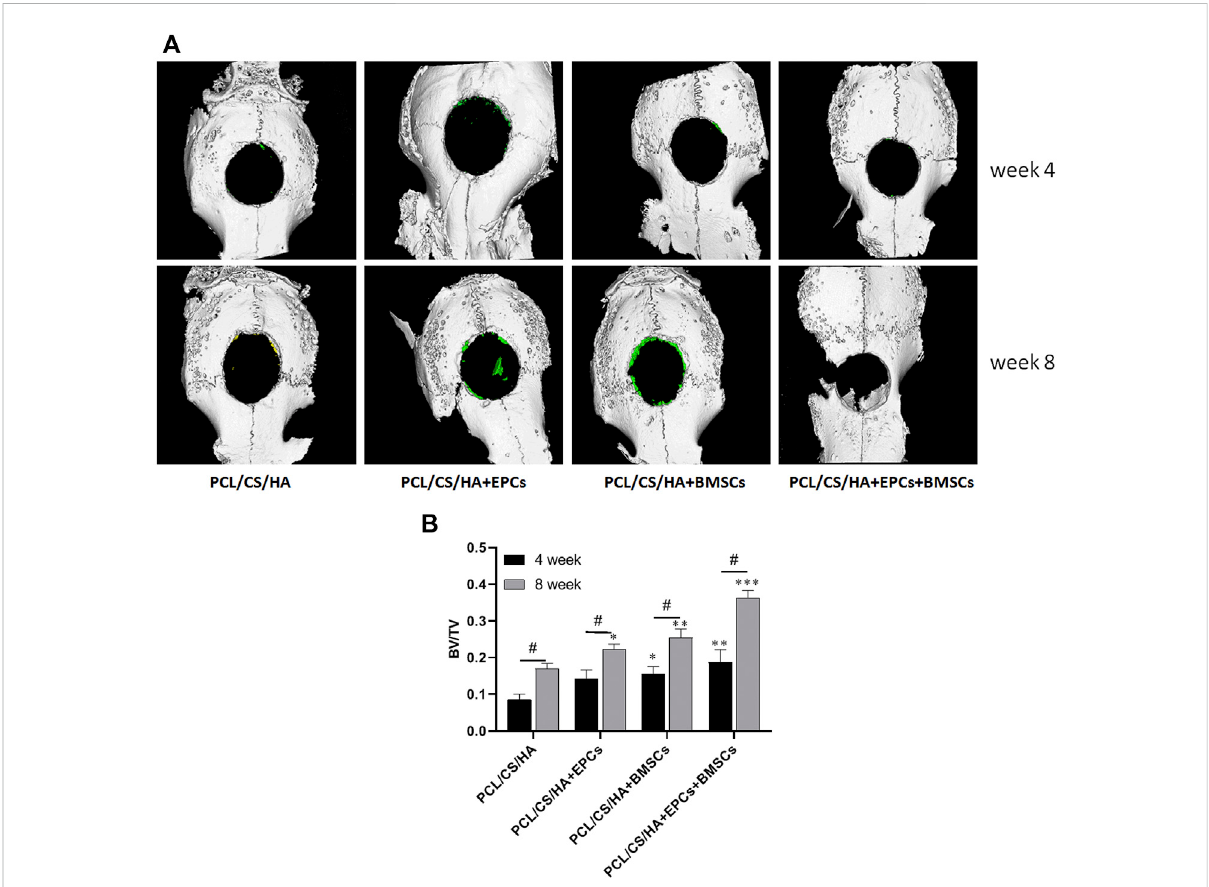
FIGURE 8 Three-dimensional micro-CT images of calvarial defect areas. The representative images (A) of micro-CT reconstruction and the quantitative data of BV/TV (B) from micro-CT evaluations of the four groups. * p < 0.05, ** p < 0.01, *** p < 0.001 vs. HA/CS/PCL group (the same time point), # p <